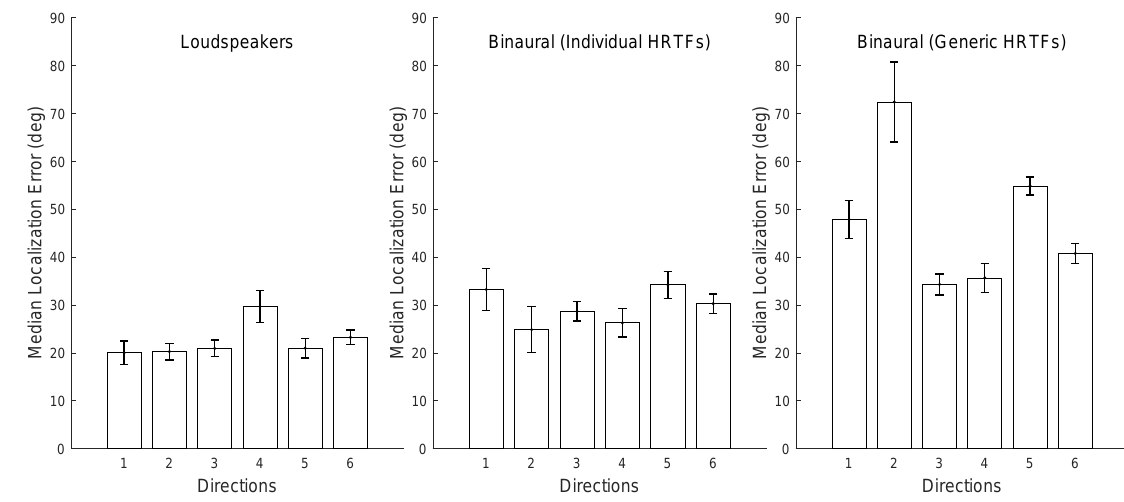
Figure A2. Median localization error for each virtual sound source direction at different reproduction methods. The whiskers indicate non-parametric 95% confidence intervals